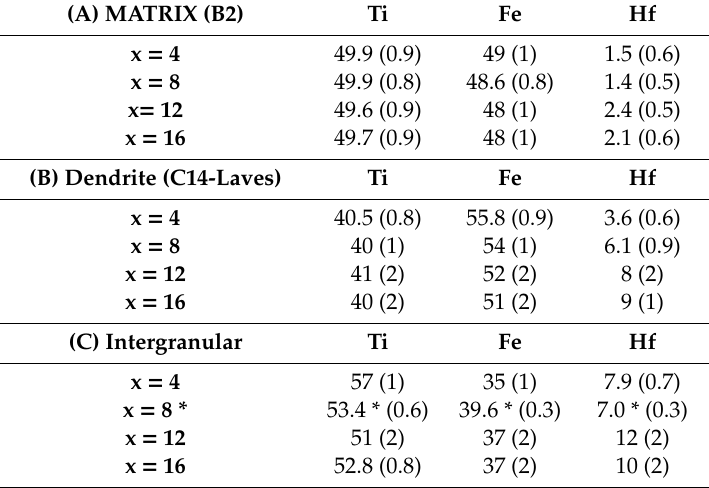
Table 2. Compositions (in at.%) of the three phases in TiFe + x Hf alloys (with x = 4, 8 and 12, and 16 wt.% of Hf) after solidification. Experimental data.